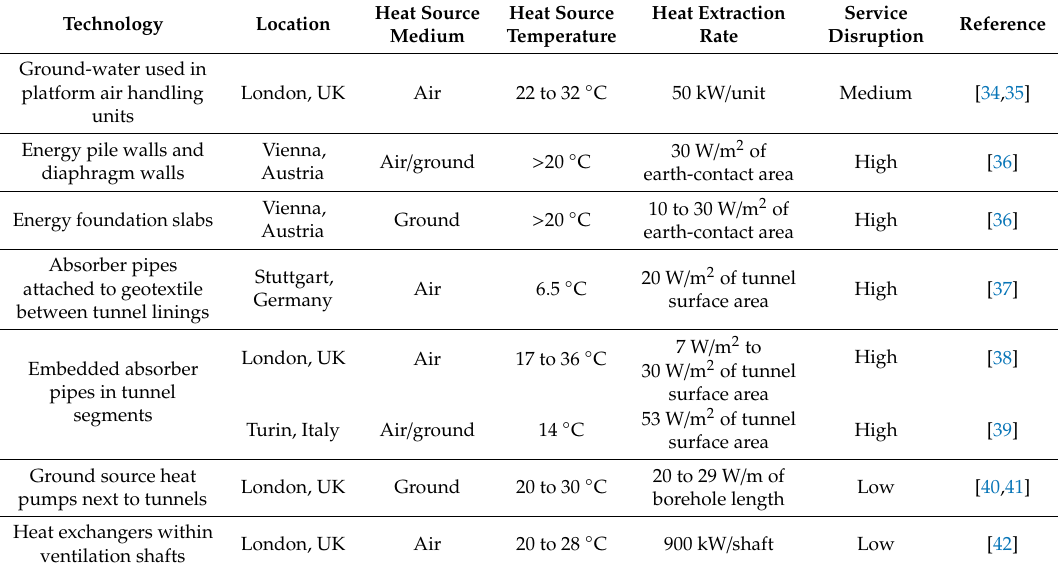
Table 2. Potential technologies for waste heat recovery from underground railway